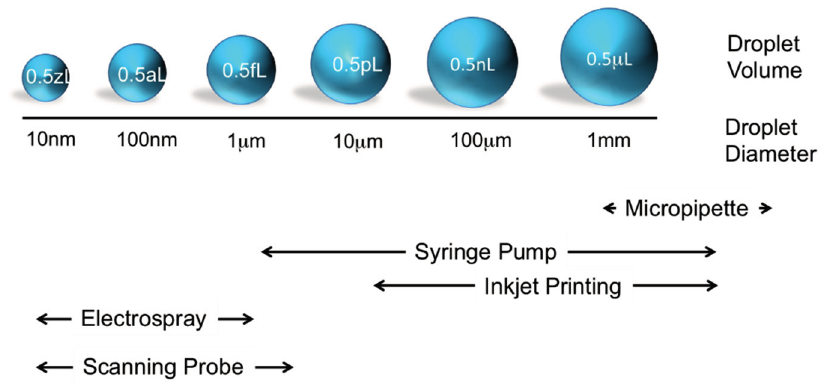
Figure 1. Various dispensing techniques and their respective droplet diameter and volume range that can be